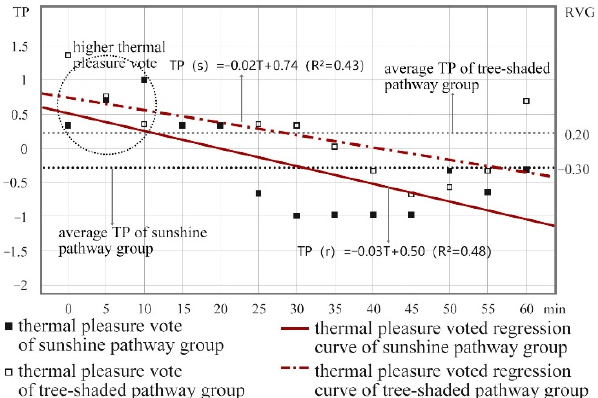
Figure 11. Voted thermal pleasure of sunshine pathway group and tree-shaded pathway group.